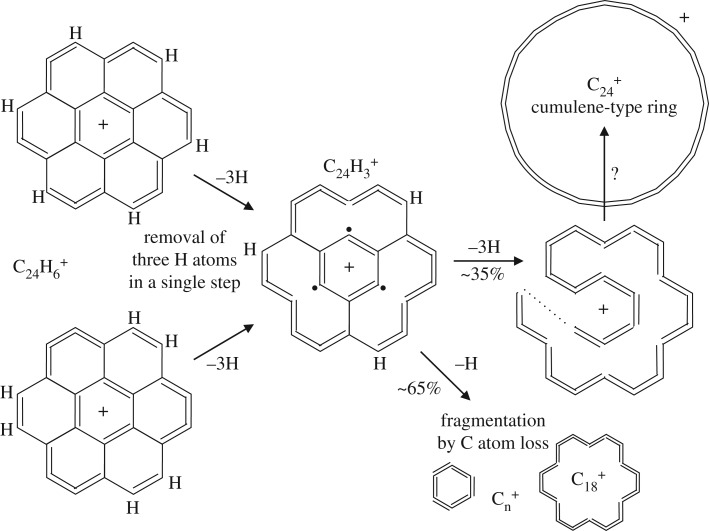
A possible pathway for the dehydrogenation of the C24H 6+ ion leading to C 24+, which is assumed to have a cumulene-type ring structure.